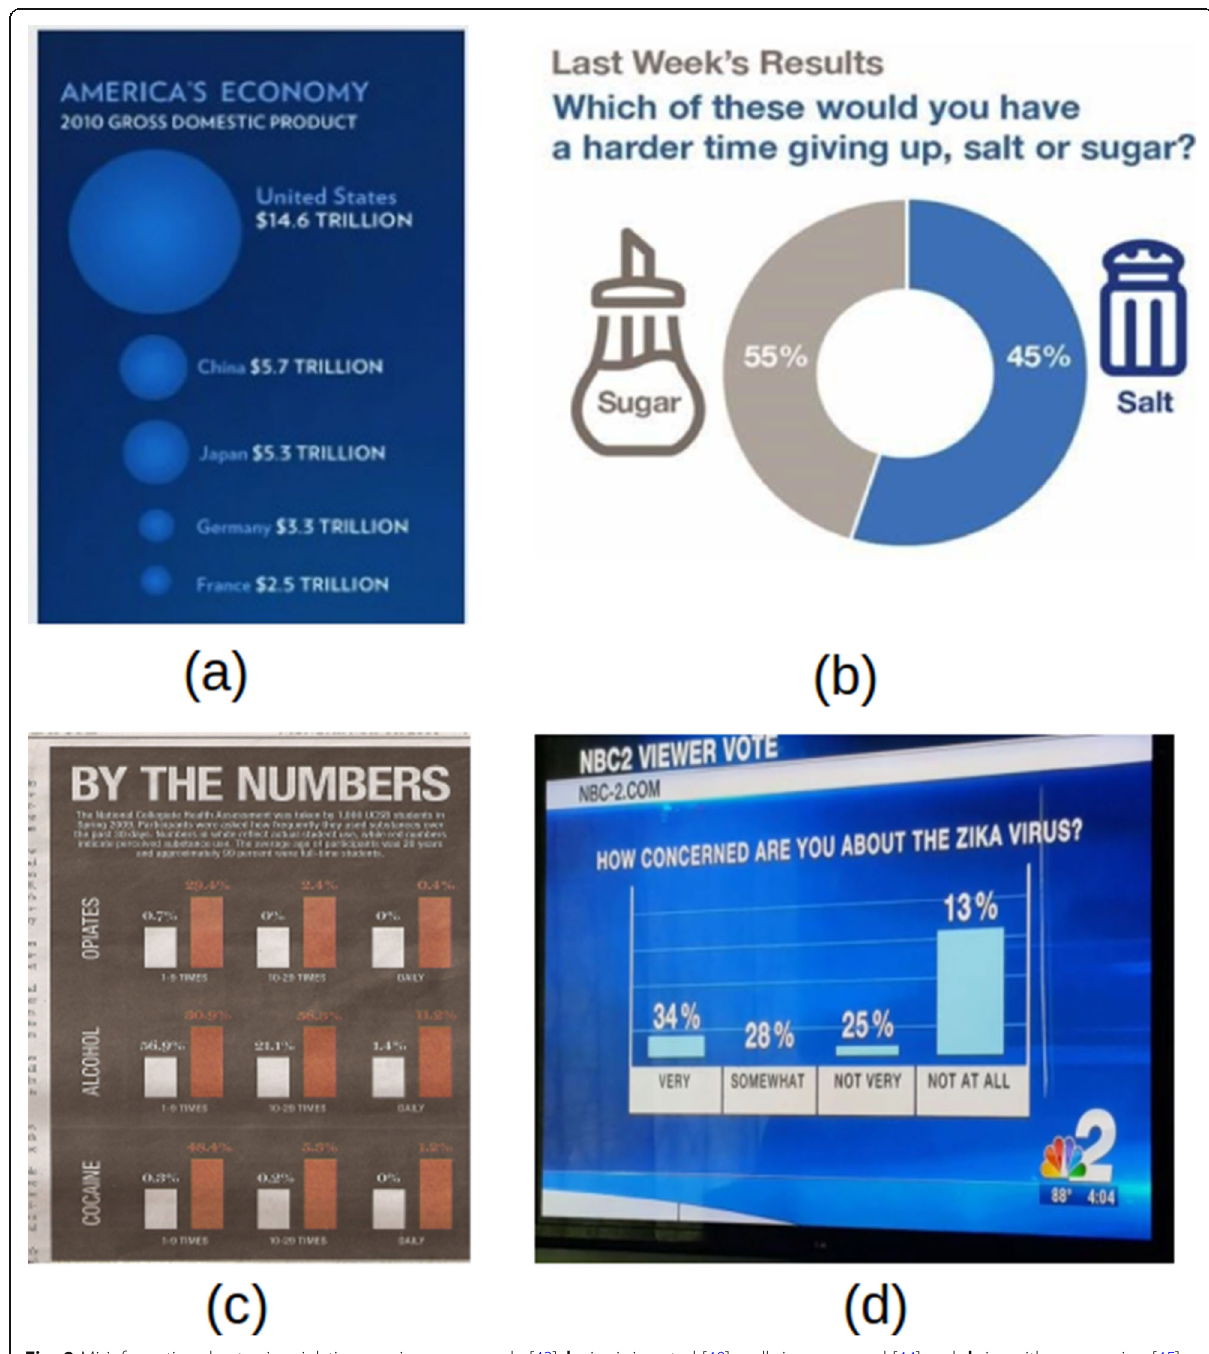
Fig. 8 Misinformation due to size violation: a using wrong scale [43], b size is inverted [40], c all sizes are equal [44] and d size with no meaning